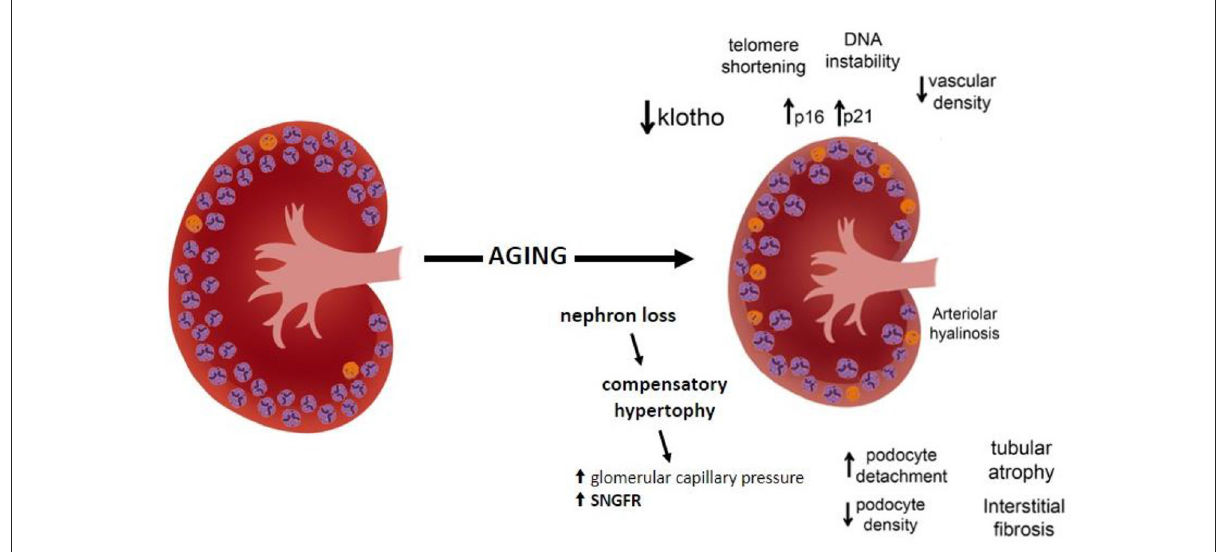
FIGURE1 Schematic structural and functional changes in the aging kidney.